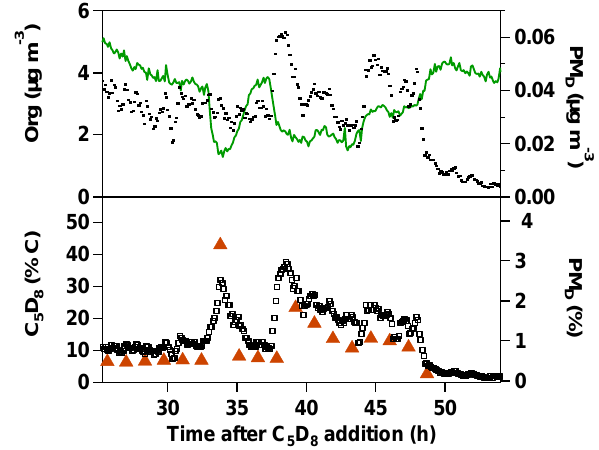
Fig. 4. SOA was produced by OH-initiated oxidation of VOCs re- leased from an ozone stressed non-isoprene emitting poplar (98– 126ppbC), and C 5 D 8 (6–80ppbC) with absolute concentrations of organics (green line, left scale) and PM D (black filled squares, right scale) given in the upper panel. Contribution of deuterated isoprene (C 5 D 8 ) to the gas phase (red triangles, left scale) and contribution of PM D (black open squares, right scale) to SOA formed from the mixture are shown in the lower